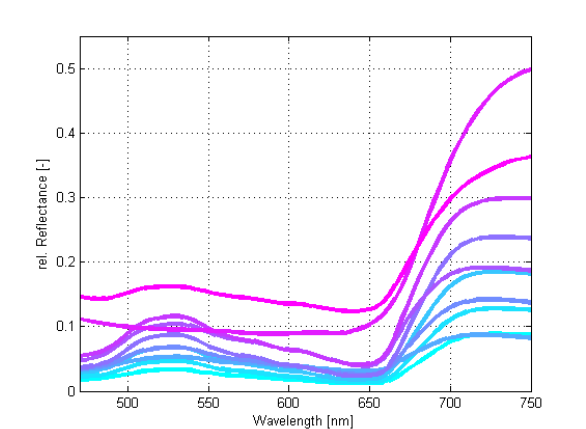
Figure 3: Centroids of the cluster for the labeling of the bar- ley data set. The transition from blue to magenta represents the senescence states of the corresponding spectra.